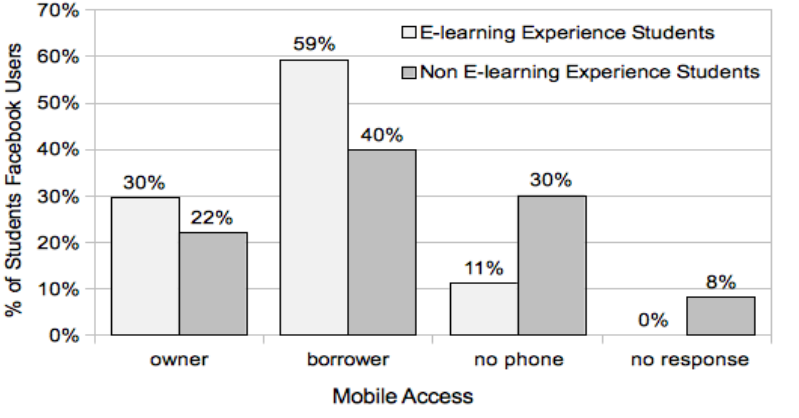
Figure 11. Mobile access to